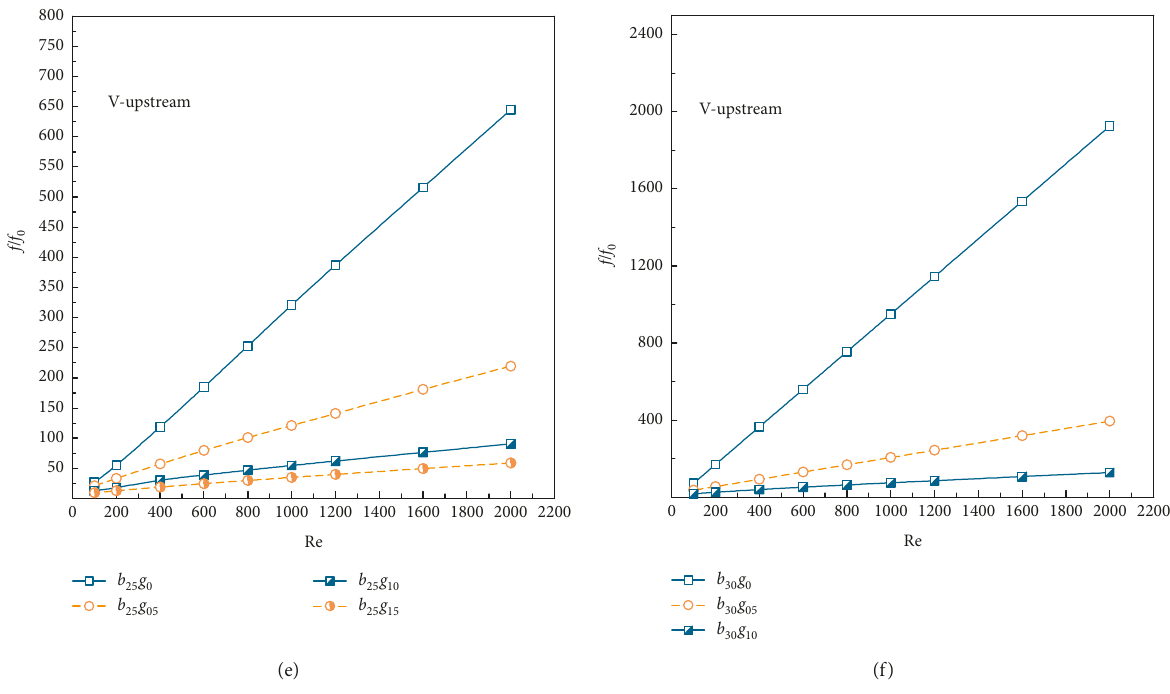
Figure 14: Relation of f / f 0 with the Reynolds number for (a) b05, (b) b10, (c) b15, (d) b20, (e) b25, and (f) b30 at V-upstream arrangement.